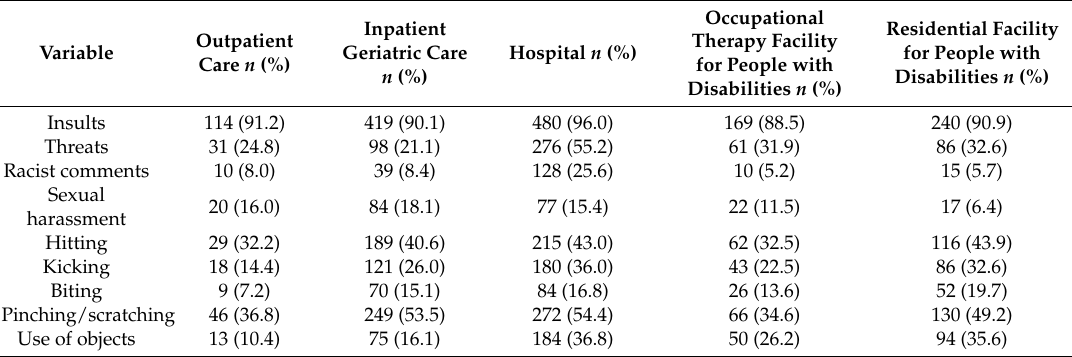
Table 3. Types of violence * in the previous twelve months by area of work.